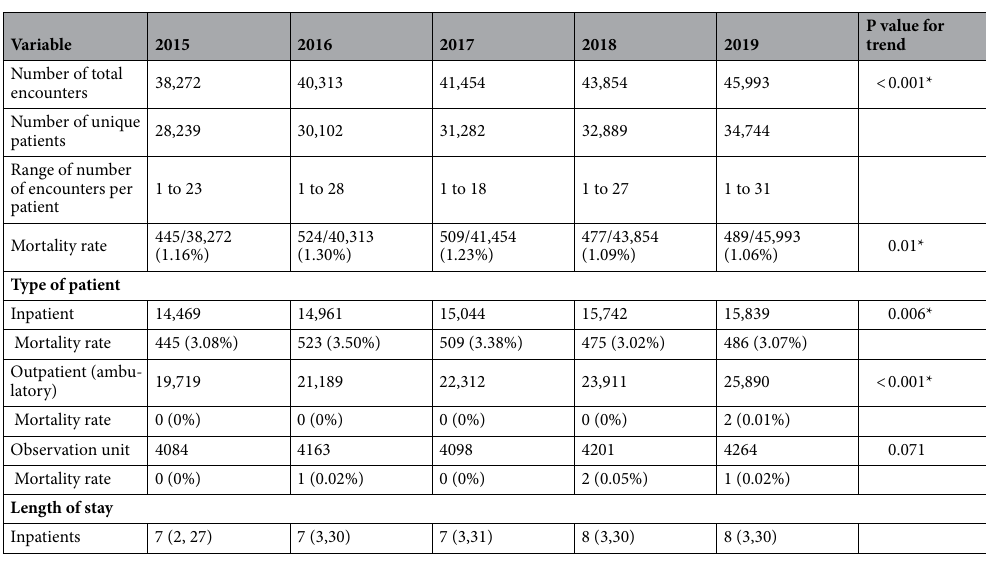
Table 2. Description of number of encounters, patients, mortality rate and length of stay. Observation means stay strictly less than 24 h.